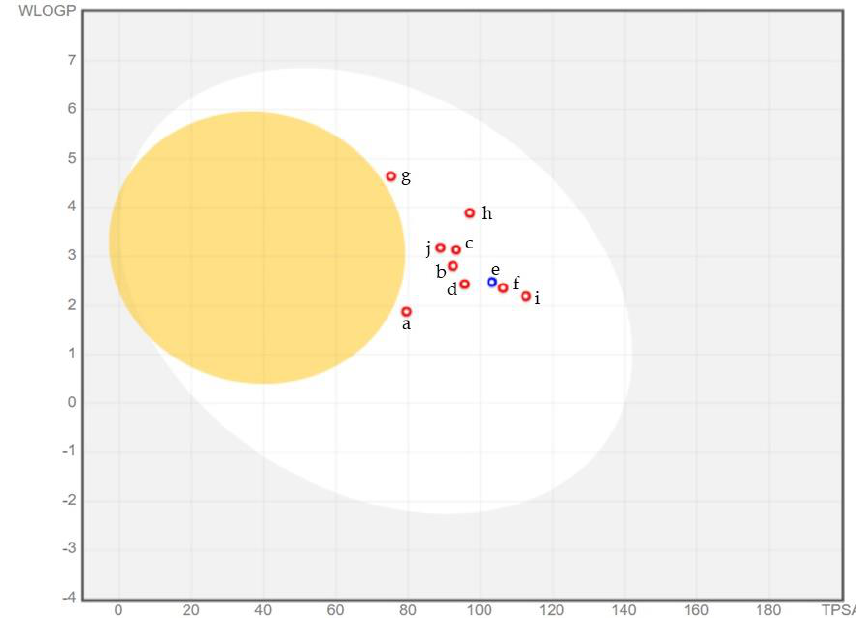
Table 3. Owing to pharmacokinetic properties, all the hits have high gastrointestinal ab- sorption and were unable to cross the blood – brain barrier (BBB) depicting the safety of central nervous system, as shown in Figure 9 via the boiled egg. This study aims to syn- thesize drugs that will work outside the central nervous system (CNS) so drugs that will not cross the blood – brain barrier are preferred. The inhibition of cytochrome P450 (CYP) varies, while all obeyed Lipinski, Ghose, Veber, Egan, and Muegge drug-likeness rules with a 0.55 bioavailability score. Furthermore, no PAINS alerts have been observed and